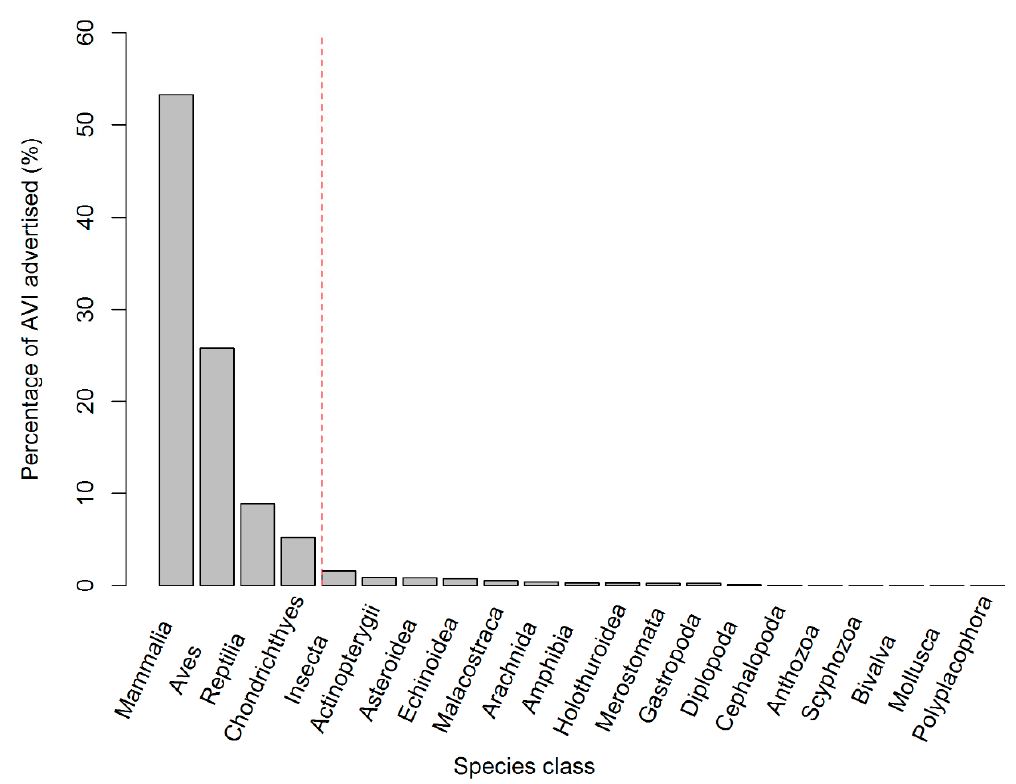
Figure 7. Percentage of advertised AVIs split by species class. A significant difference between the observed frequency of AVIs per species class and those expected by an even distribution ( χ 2 = 33,940, df = 20, p < 0.001), with Mammalia, Aves, Reptilia and Chondrichthyes having a higher AVI frequency than expected (left of the dashed red line).